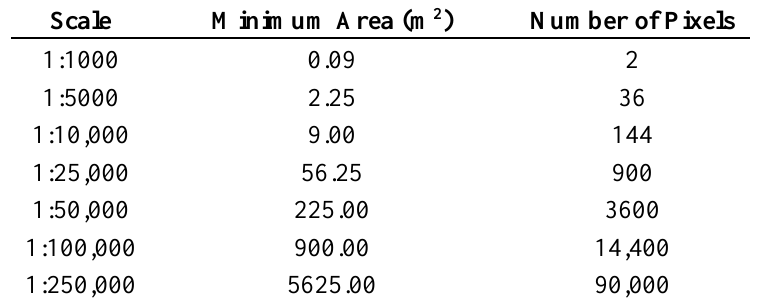
Table 1. Minimum area and corresponding number of pixels at each large and medium